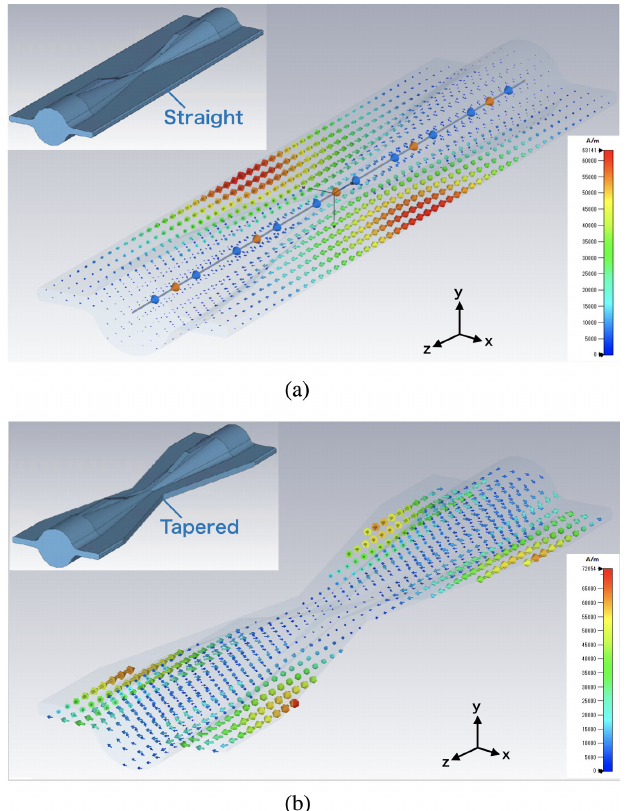
FIG. 6. Simulation model and magnetic field strength in (a) straight and (b) tapered antechambers, calculated with CST STUDIO . The tapered height at the center of the collimator is 70 mm. The mode and the resonance frequency are TE 111 ;y and 0.7536 GHz in the straight shape, TE 112 ;y and 1.1683 GHz in the tapered shape,